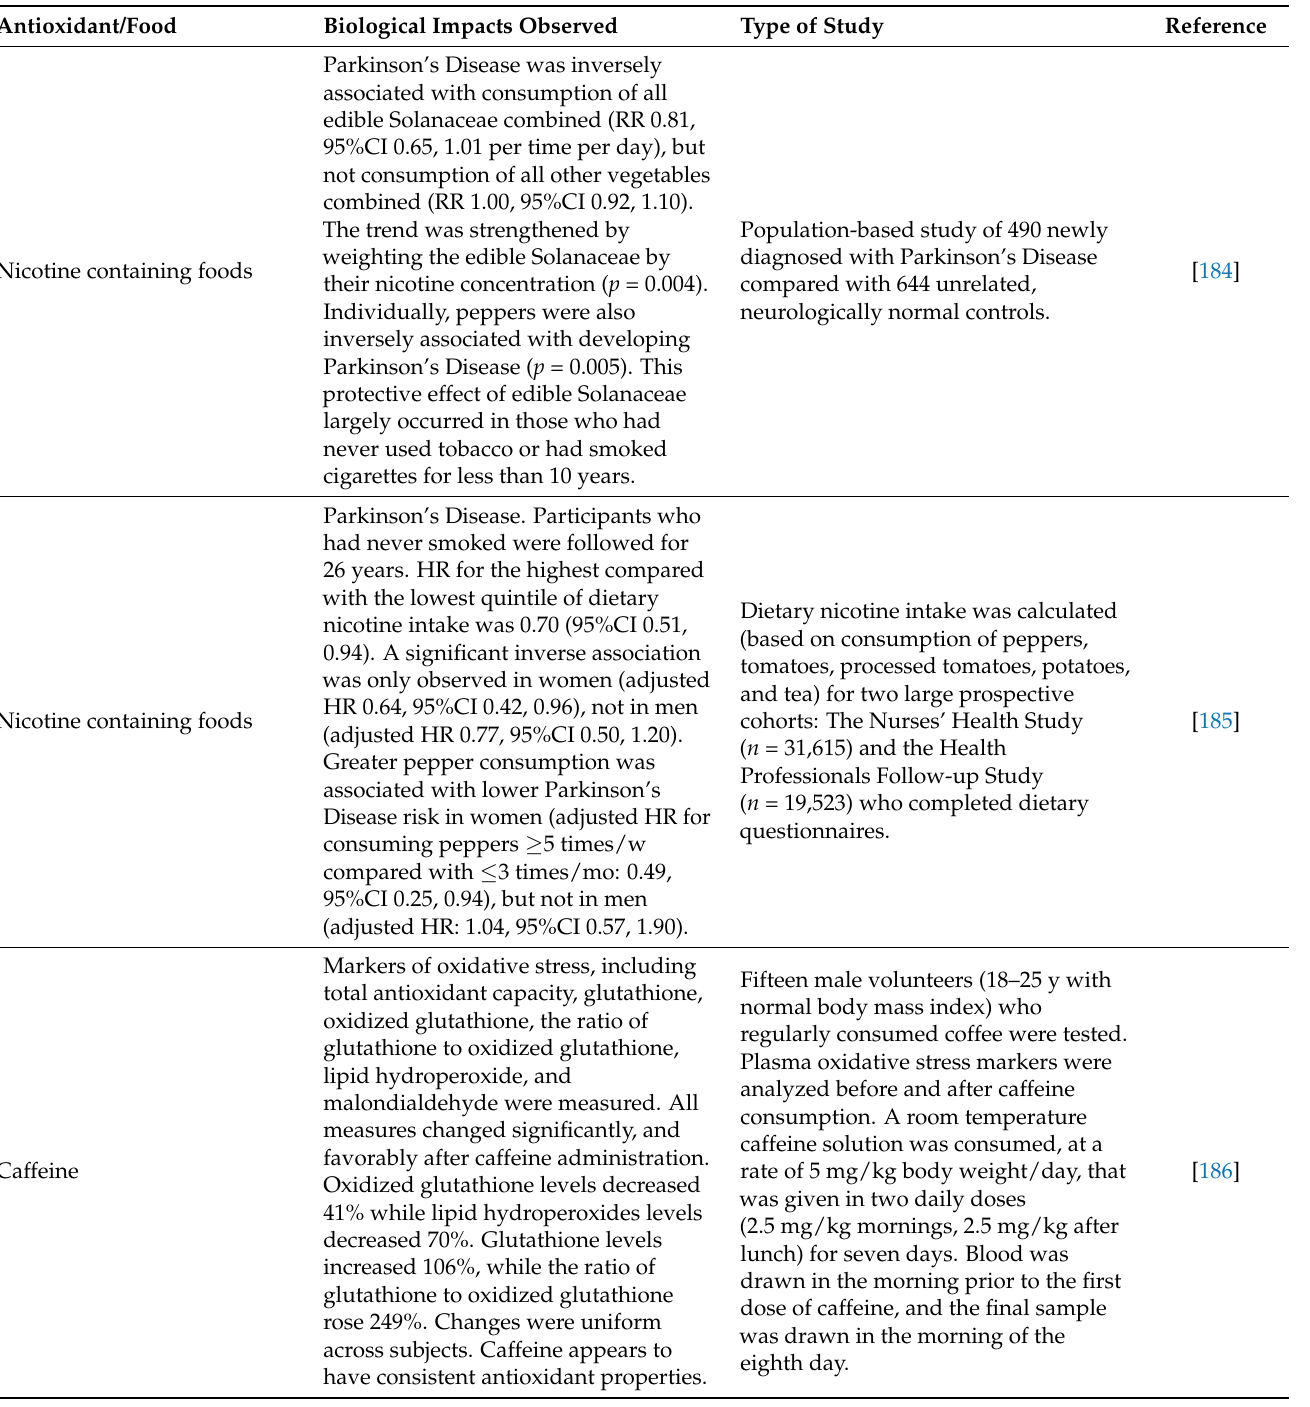
Table 6. Parameters and pertinent results from cited studies examining health outcomes associated with dietary alkaloids. RR = Relative risk, HR = Hazard